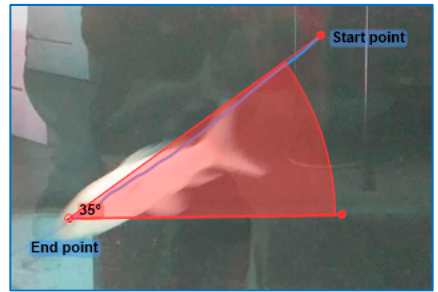
Figure 7. Descending pattern of the carp during 1.05 s.